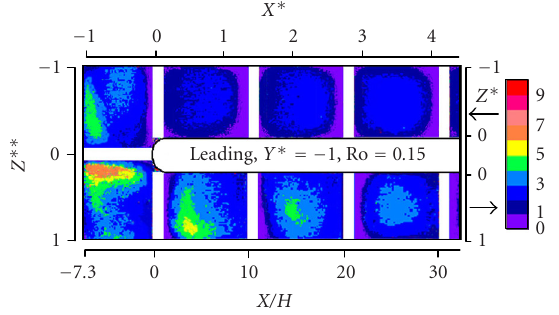
Figure 3: Detailed local Nusselt number ratio distribution for Ro = 0 . 15 and Re = 1 . 0 × 10 4 on the leading wall